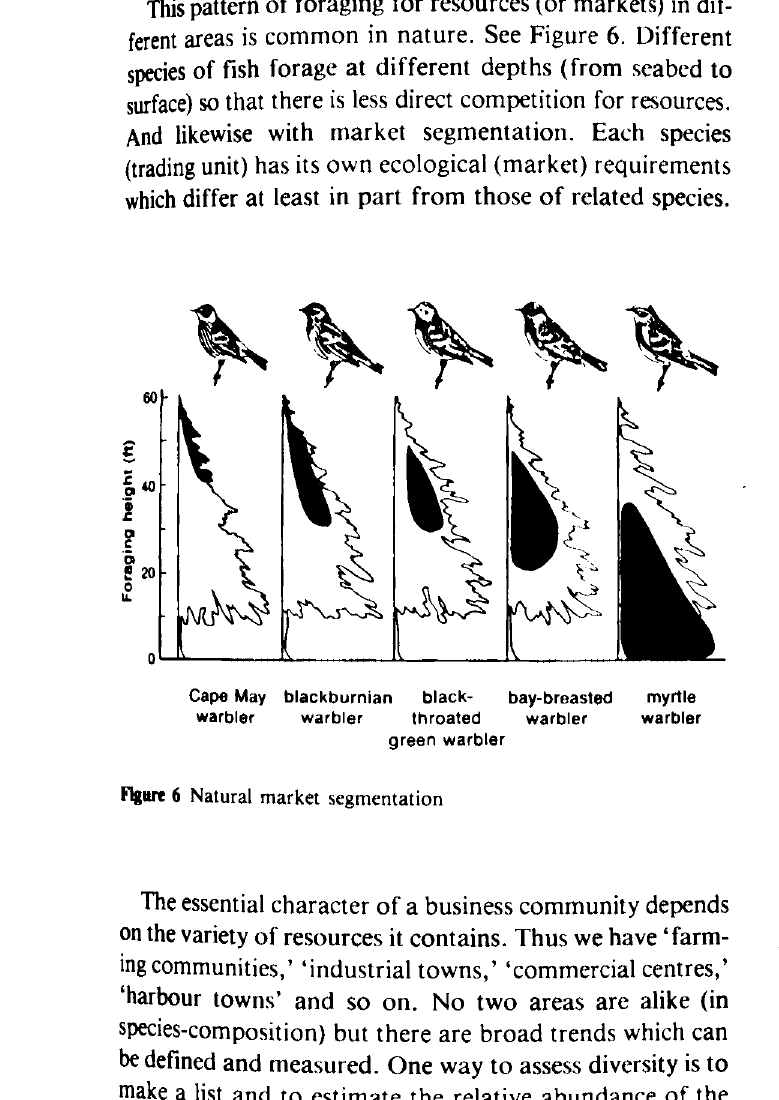
Figure 7 Organization diversity and